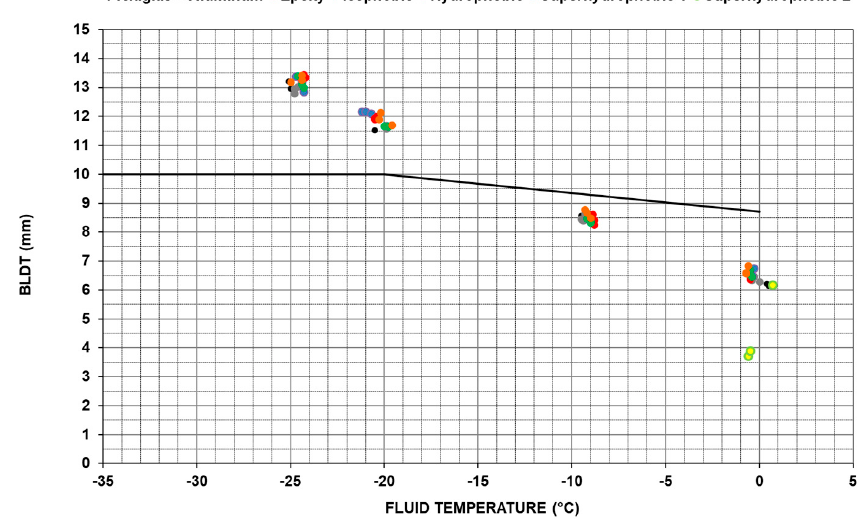
Figure 14. BLDT results for all surfaces in function of temperature for Ref. Fluid (flat line showing acceptance limits).